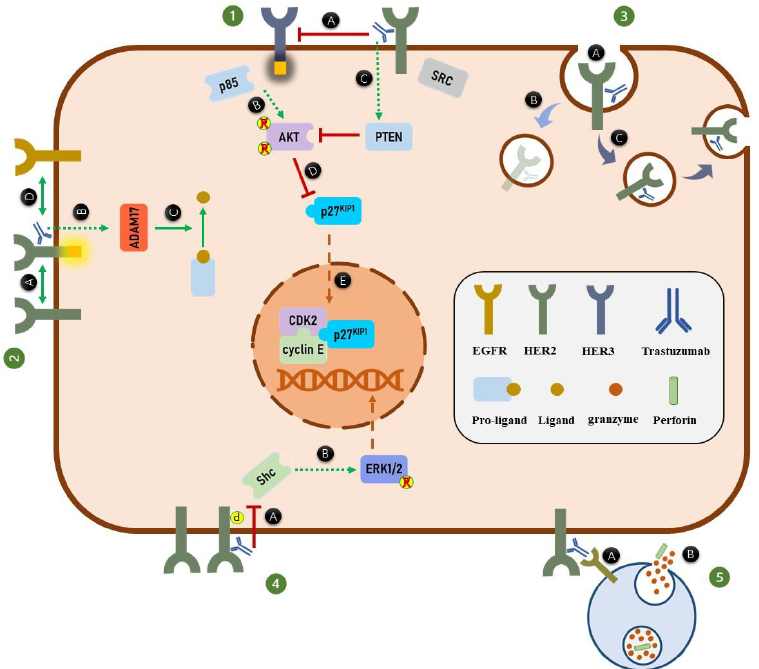
Figure 3. Trastuzumab mechanisms of action. ( 1 ) Binding of trastuzumab to HER2 receptors inhibits ( A ) the ligand-inde- pendent HER2-HER3 heterodimer formation, HER3 phosphorylation, and ultimately association of p85 to HER3 recep- tors. ( B ) Inhibition of PI3K complex formation inhibits AKT phosphorylation. Moreover, ( C ) trastuzumab inhibits AKT phosphorylation through activation of PTEN phosphatase activity. ( D ) Inhibition of AKT phosphorylation,